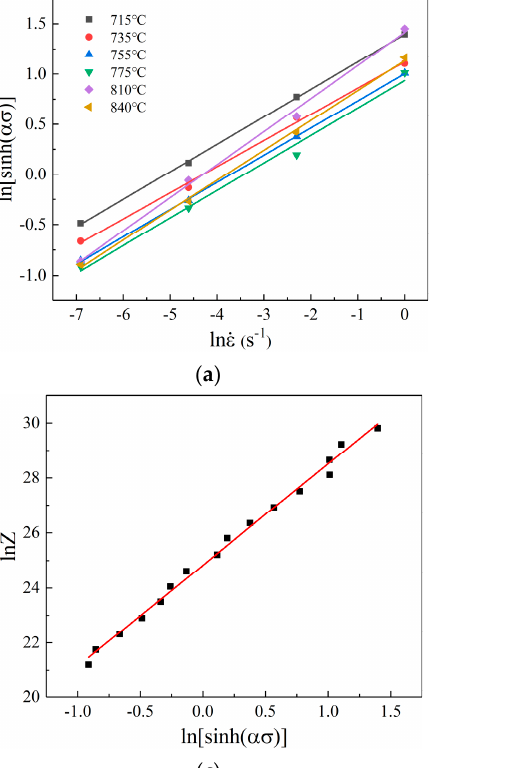
Table 3. Activation energy for several typical high strength-toughness titanium alloys.